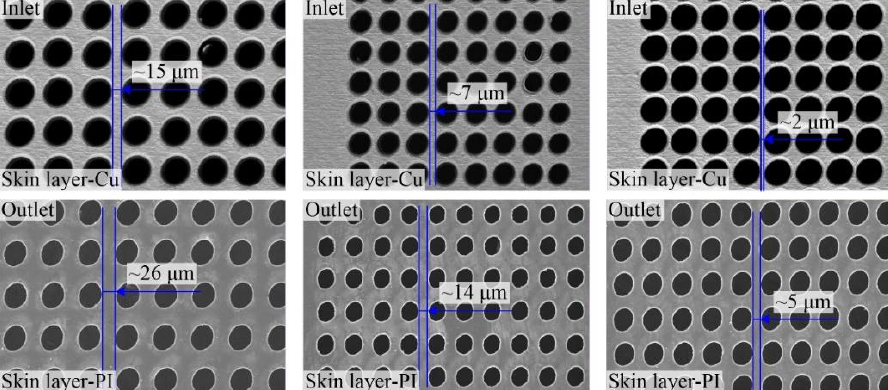
Figure 9. SEM images of through-holes with multiple inlet pitches in single-sided board.